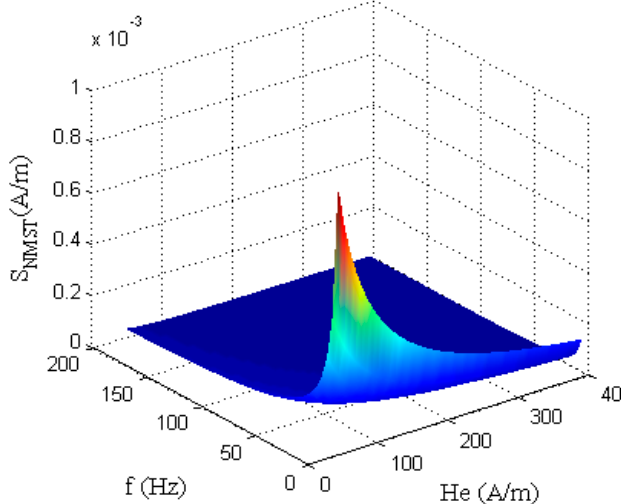
Figure 6. The relationship between S NMST and H e ( t ).